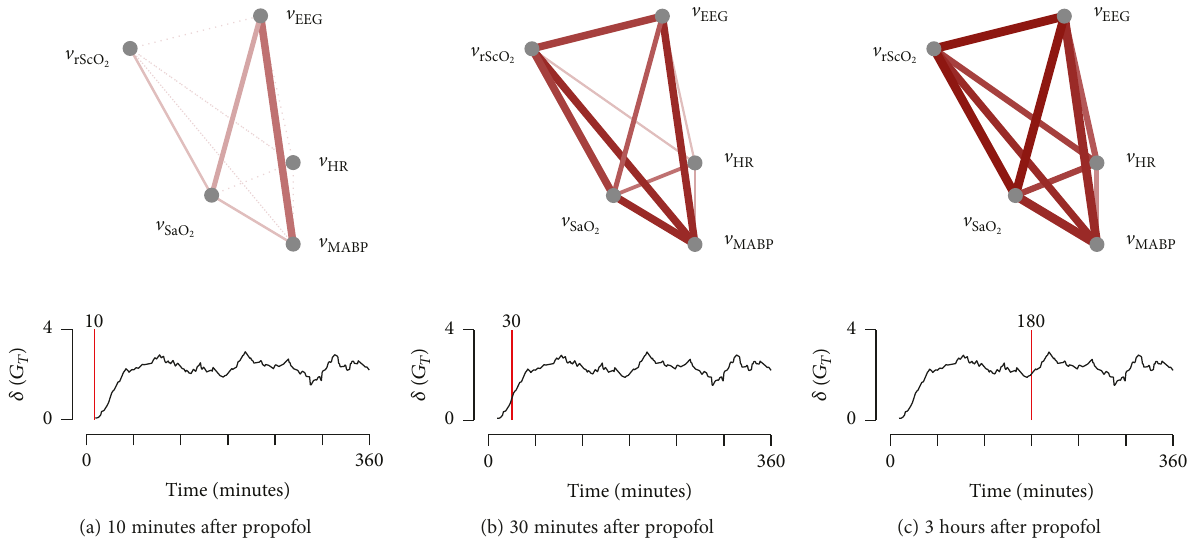
Figure 7: Changes in the physiological network, assessed using a graph model G T , for one neonate in the group of study (PMA 30 weeks, 1.0mg · kg − 1 ) at three di ff erent time instances: plots (a), (b), and (c) illustrate the edge weights for t =10, 30, and 180 minutes after propofol administration, respectively. The graph model was constructed using k T x i , x j de fi ned in (2). Under each graph, the average graph degree δ G T is presented in a time frame starting right after propofol administration ( t =0) up to 6 hours after. The average graph degree measures the average connection strength of the graph edges. From (a) to (c), the edge weights increase, which translates in an increased δ G T